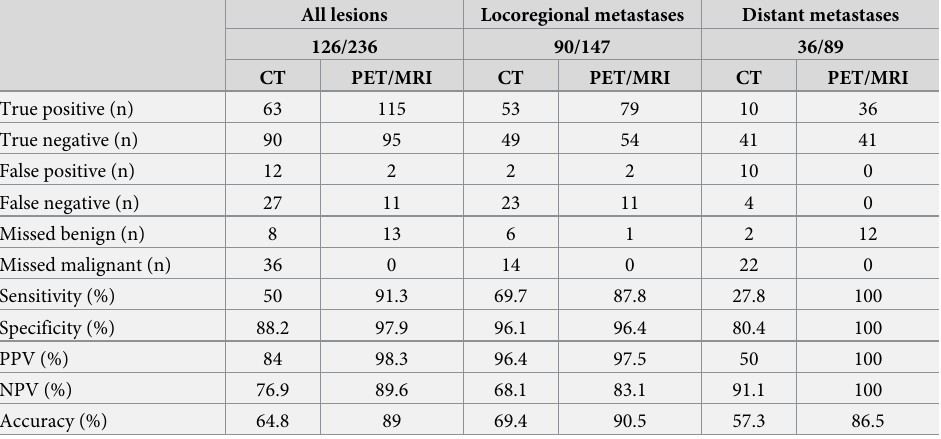
Table 4. Diagnostic performance of CT and PET/MRI on a lesion-based